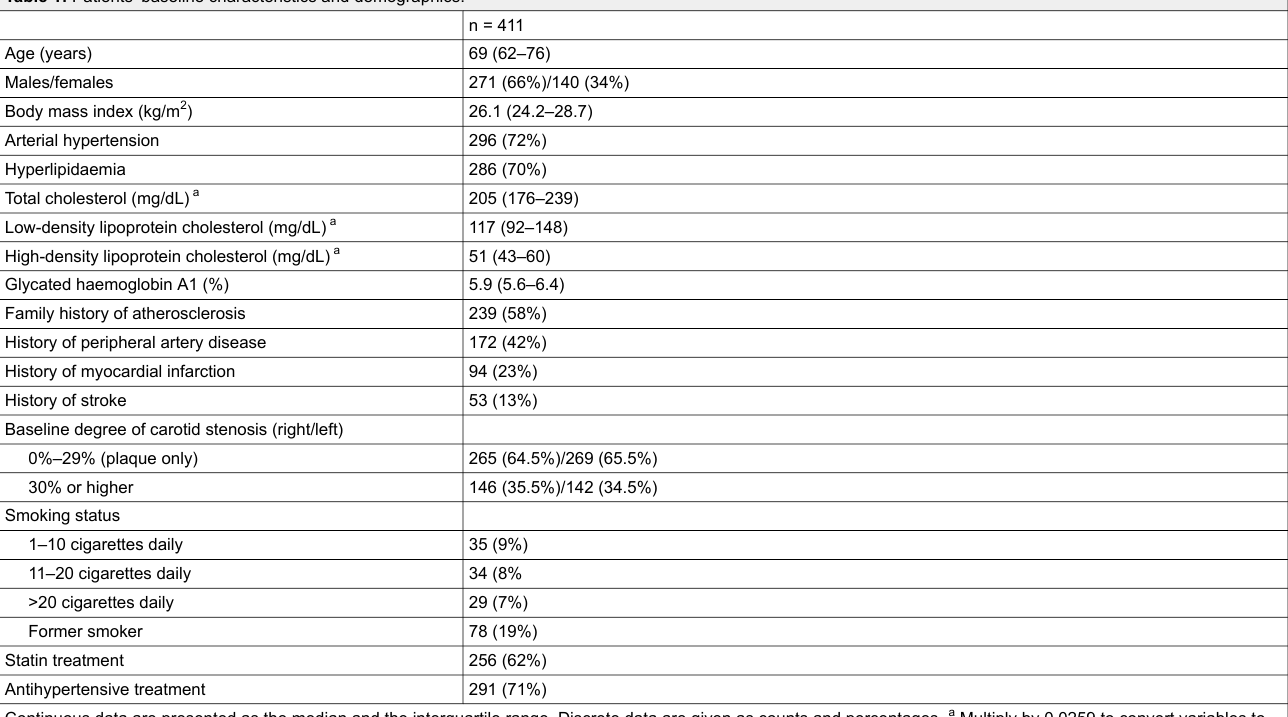
Table 1: Patients’ baseline characteristics and